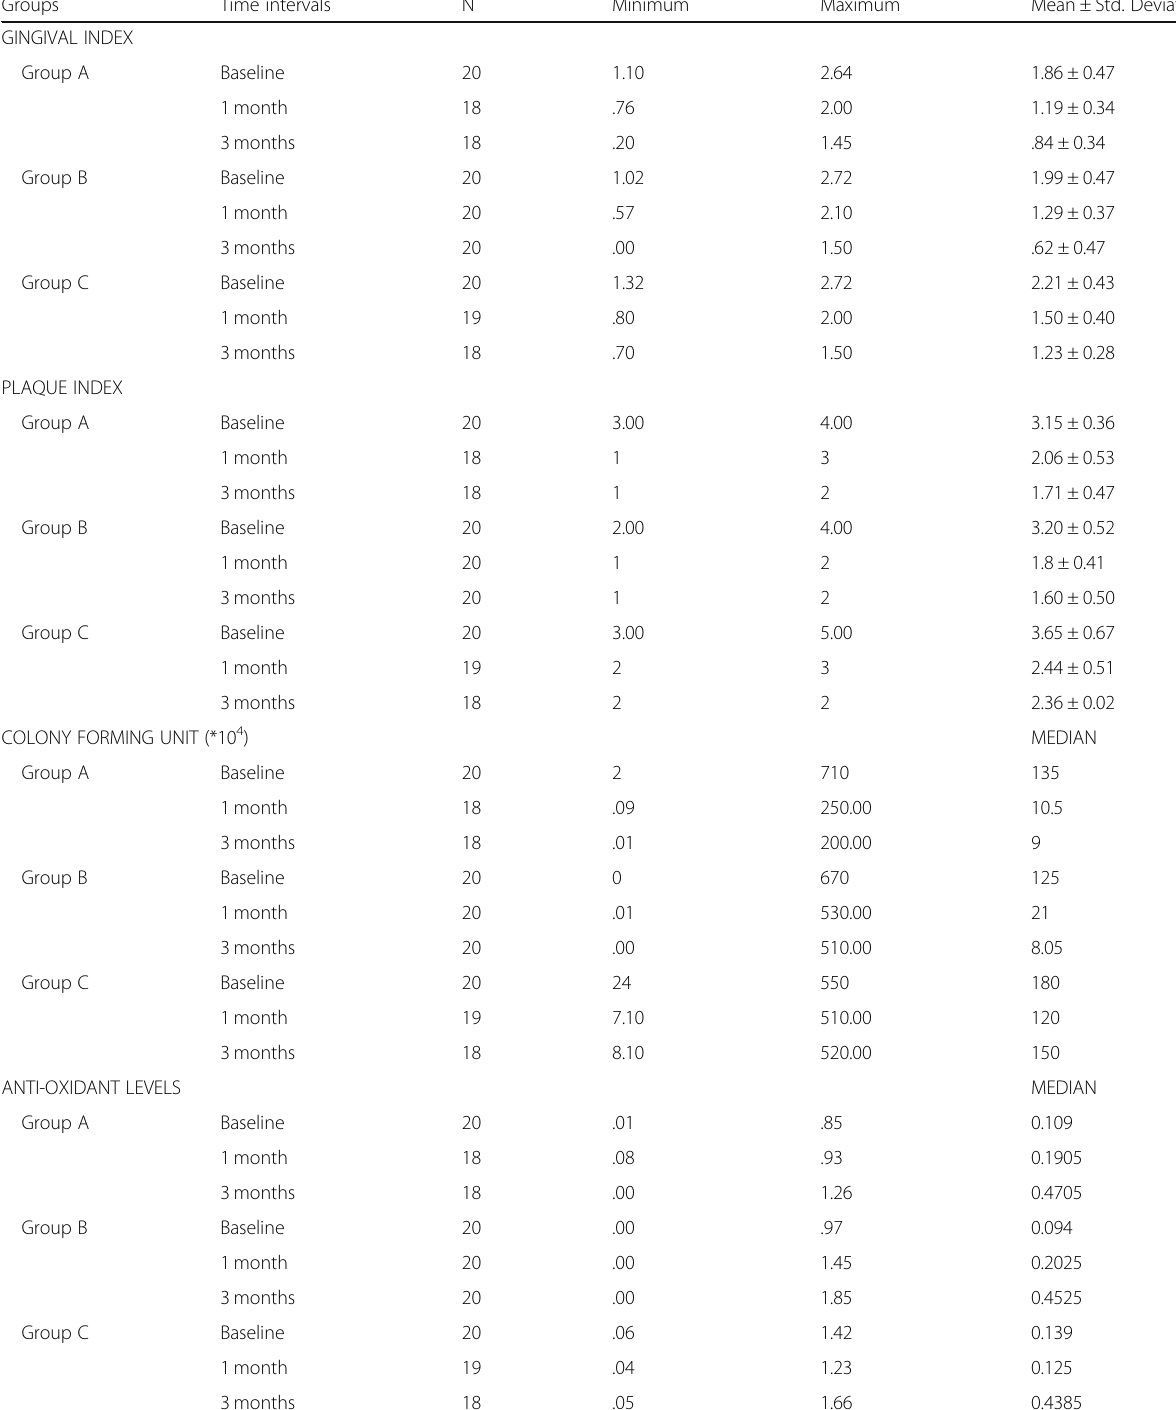
Table 2 Description of clinical parameters among the test groups at different time intervals Groups Time